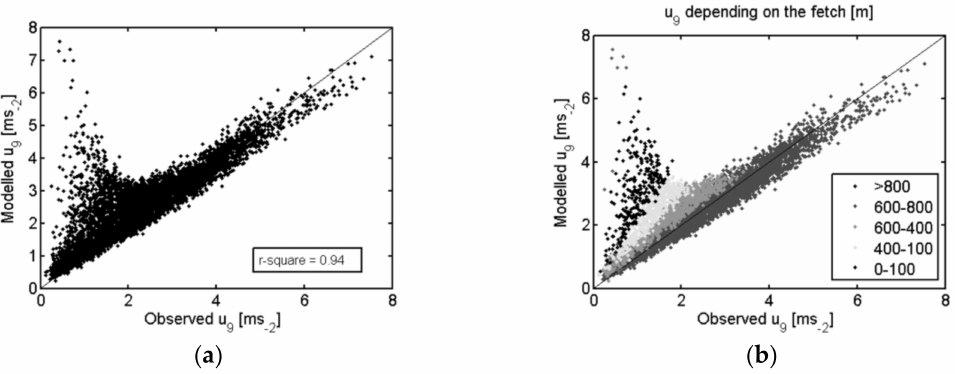
Figure 5. ( a ) wind-speed estimated and measured at 9 m on Las Majadas site; and ( b ) in relation to the fetch.